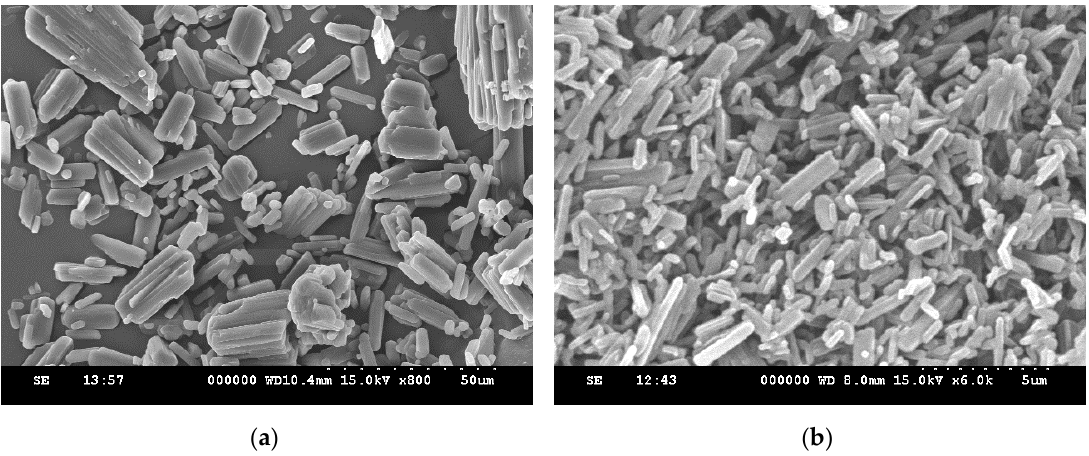
Figure 3. SEM images of ( a ) unprocessed ethenzamide and ( b ) RESS-processed ethenzamide from Experiment 12.